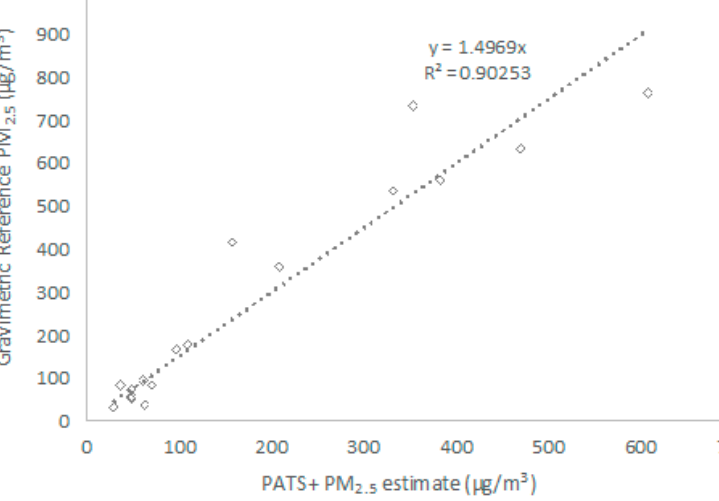
Figure 2. Correlation between the PATS+ estimate of PM 2.5 ( µ g/m 3 ) and collocated gravimetric samples of PM 2.5 ( µ g/m 3 ) from a PATS+ field performance test in the kitchens of families using traditional wood burning cookstoves in Alotenango, Guatemala. PATS+ units were individually calibrated against wood smoke in the lab.